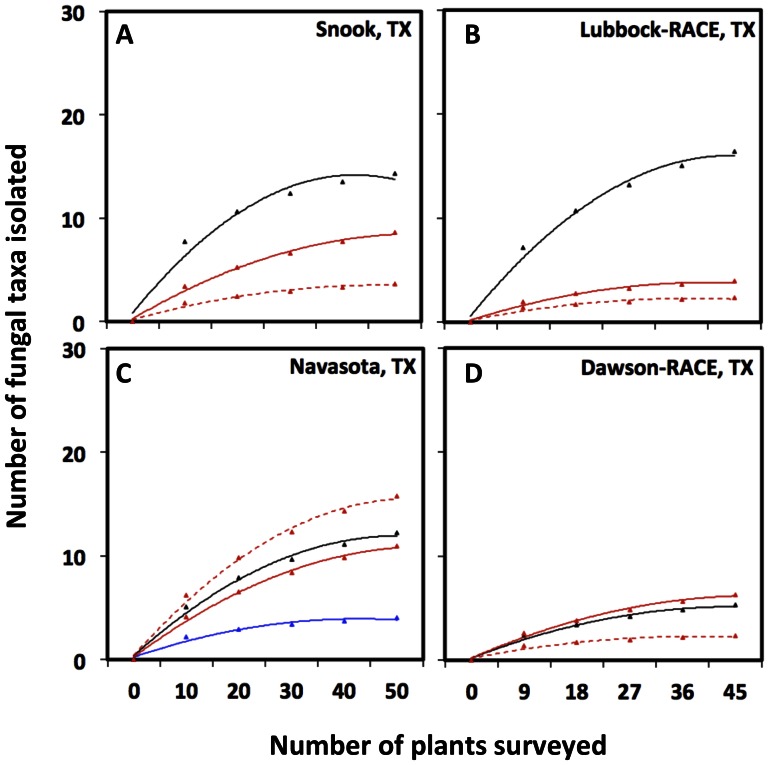
Accumulation curves of fungal taxa isolated from leaves, squares and squares/bolls.The graphs show the relationship between the number of fungal taxa isolated and the number of plants surveyed in (A) Snook, TX, (B) Lubbock-RACE, (C) Navasota, TX and (D) Dawson-RACE. Black continuous line = Leaves surveyed in June 2011, Blue continuous line = Squares surveyed in June 2011 (Navasota, TX), Red continuous line = Leaves surveyed in August 2011 and Red dashed lines = Squares/Bolls surveyed in August 2011. Whole endophyte communities were considered per tissue and location, as cotton variety did not appear to have effect on Shannon-Wiener biodiversity indexes in the farms managed under conventional practices as shown in Figure 3.